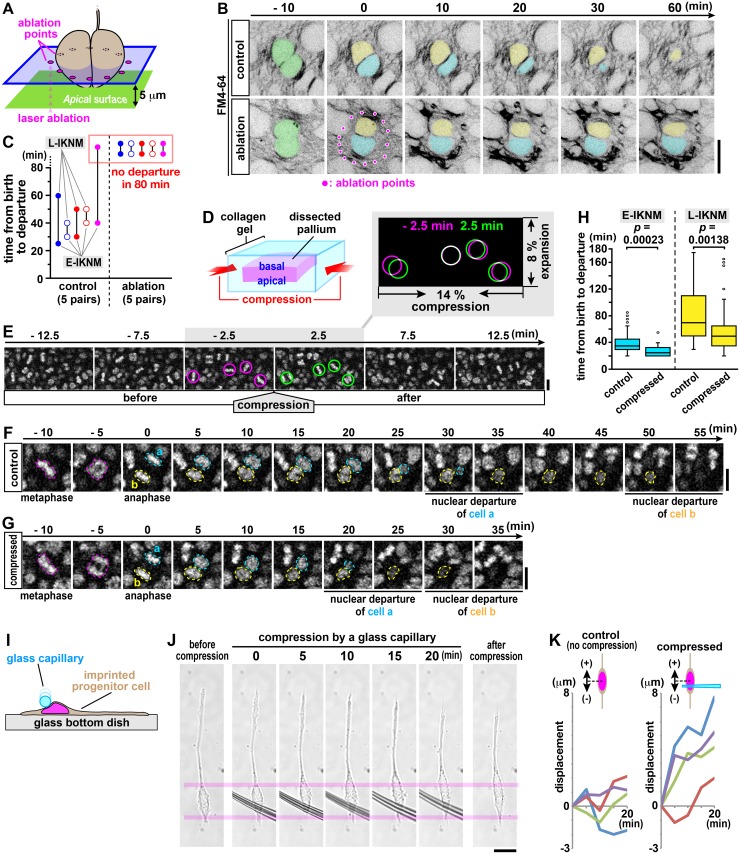
Decompression and compression experiments support the elasticity-based passive nucleokinesis mechanism.(A–C) Artificial shrinkage of the process-rich subapical space by laser ablation (at 5 μm deep, as illustrated in A; circularly darkened in FM4-64 imaging, B; see also S3F Fig and S19 Movie) inhibited the initial basal displacement of daughter cells’ nuclei/somata (n = 5 pairs, C) (see also S18 Movie). (D and E) Unidirectional centripetal compression of a cerebral wall (with a device, as shown in D) increased the nuclear density in the subapical space (E; see also S3G Fig and S20 Movie). (F–H) Initial nucleokinesis from the compressed/deformed subapical space (G; H2B-mCherry–labeled) was quicker than that from the uncompressed subapical space (F). Time until departure was 28 ± 8 min for E-IKNM and 60 ± 36 min for L-IKNM when compressed, whereas it was 39 ± 15 min for E-IKNM and 82 ± 39 min for L-IKNM in control (p = 0.00023 for E-IKNM and p = 0.00138 for L-IKNM, Mann–Whitney U test) (summarized in H, n = 59 pairs for control and 43 pairs for the compressed condition) (see also S21 and S22 Movies). (I–K) Compression of single “imprinted” progenitor cells. VZ cells attached to dish base, with their spindle or bipolar in vivo–like morphologies, were pressed perinuclearly by a capillary (illustrated in I, pictured in J), and their nuclei/somata underwent counter-directional displacements (exemplified in J [see also S3H Fig], summarized in K, n = 4 for both control and compression). Scale, 10 μm in B, E, F, G, and J. Underlying data can be found in S1 Data. E-IKNM, early-nucleokinetic; L-IKNM, late-nucleokinetic; VZ, ventricular zone.